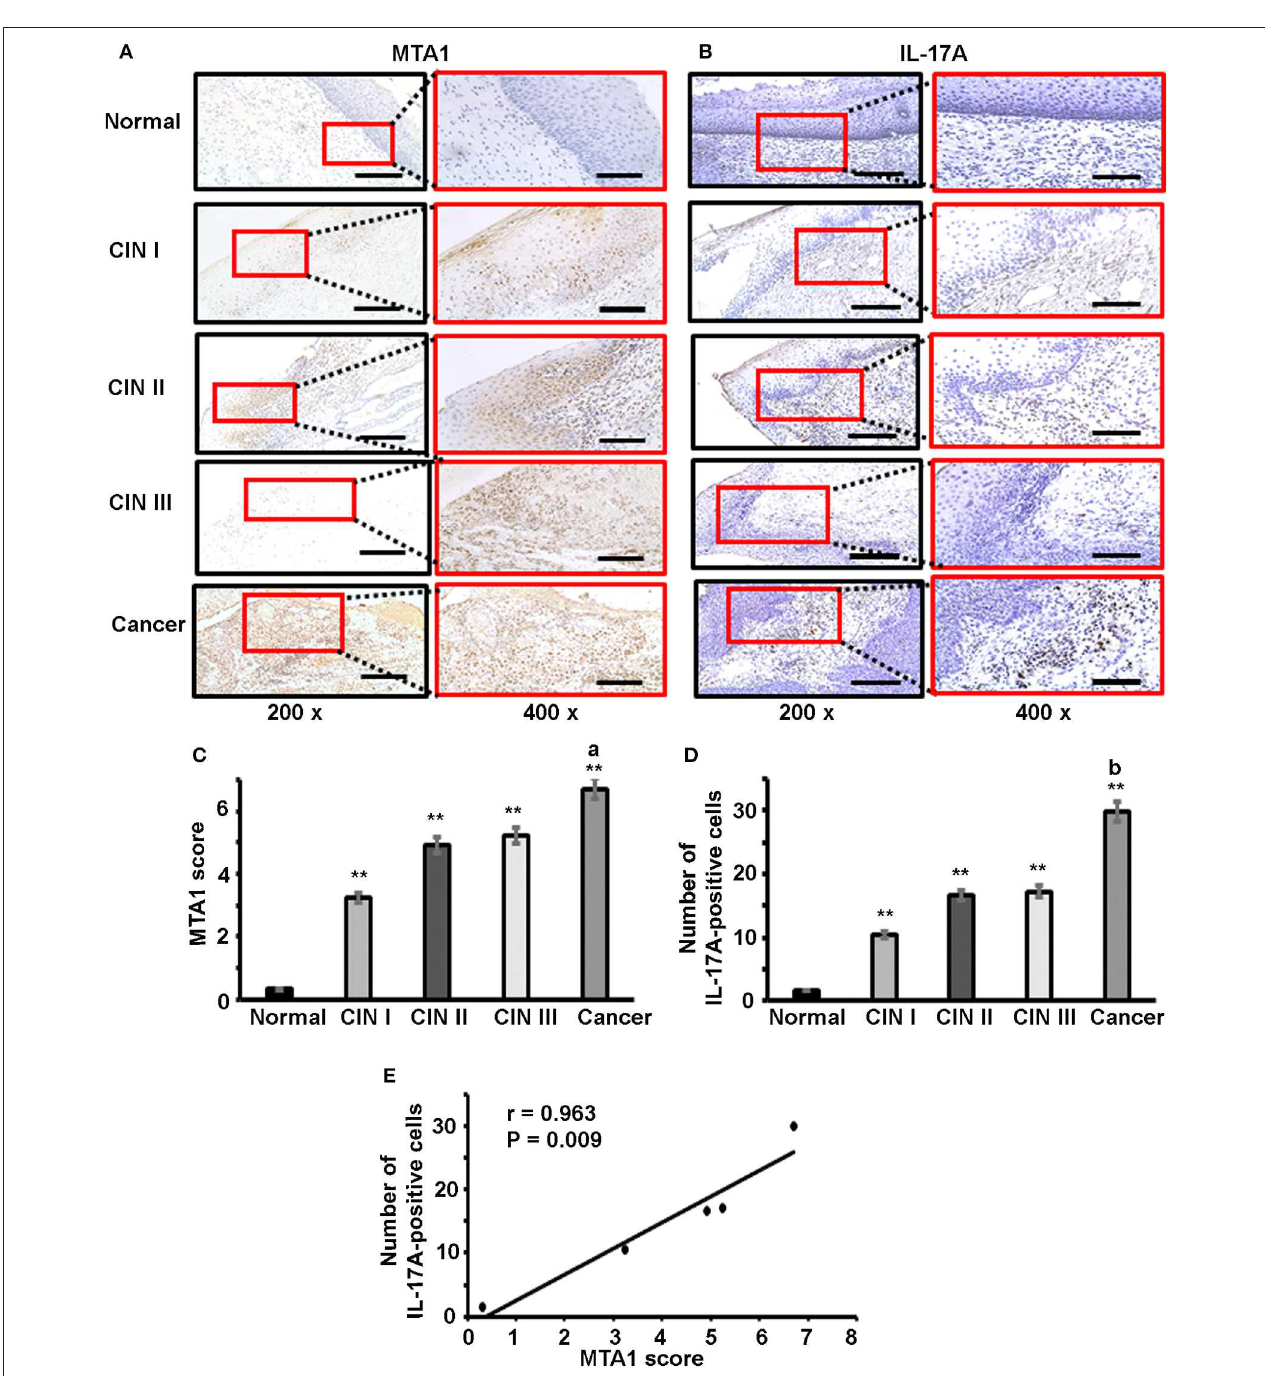
FIGURE 6 | Immunohistochemical staining of IL-17 and MTA1 protein in human cervical tissues. (A) Representative photomicrographs of MTA1 staining; scale bar, 200 µ m for 200 × magnification and 100 µ m for 400 × magnification. (B) Representative photomicrographs of IL-17 staining; scale bar, 200 µ m for 200 × magnification and 100 µ m for 400 × magnification. (C) Quantification of MTA1 staining using the Allred scoring system; data represent mean ± standard deviation (SD, error bars); ** p < 0.01 between CIN/cancer group and normal cervix group; a, p < 0.05 between cervical cancer group and CIN III group; (D) Quantification of IL-17 staining by counting the number of IL-17-positive cells; data represent mean ± standard deviation (SD, error bars); ** p < 0.01 between CIN/cancer group and normal cervix group; b, p < 0.05 between cervical cancer group and CIN III group; (E) Correlation analysis of the number of IL-17-positive cells and MTA1 score; the number of IL-17-positive cells was counted in the areas of 5 high-power (400x) fields and the average number represents each sample.